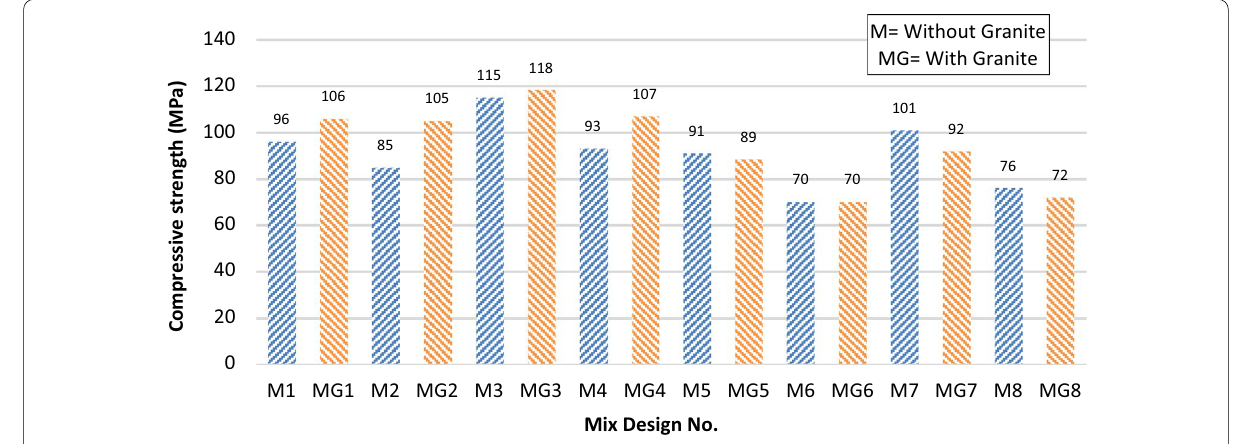
Fig. 3 Compressive strength of mixes with and without GW before heating